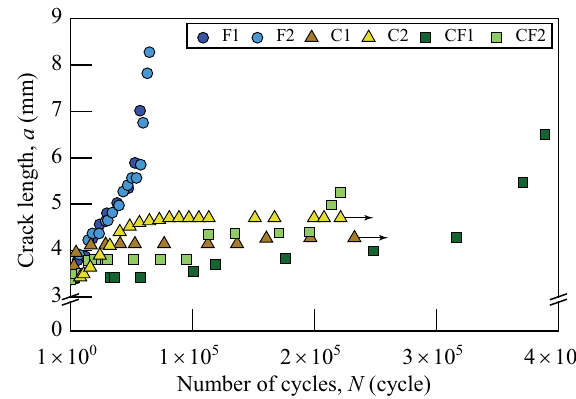
Fig. 7 Crack extension during fatigue, creep, and creep – fatigue loading. The crack length ( a ) as a function of the number of accumulated cycles ( N ) during the cyclic and constant stress-loading experiments was measured using digital image correlation. In both creep experiments, C1 and C2, the arrows indicate that the tests were halted before failure due to crack arrest. The error bars were smaller than the symbols used to denote the crack